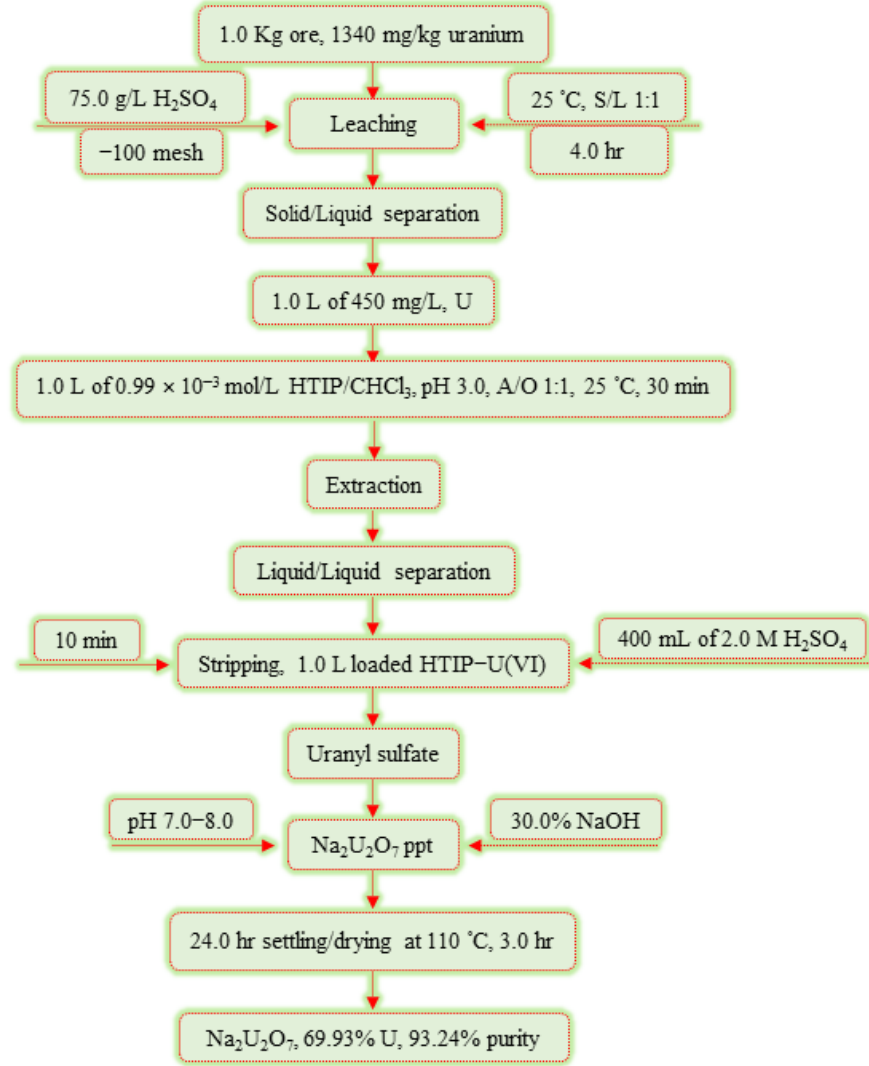
Figure 13. Flow chart illustrating the production of Na 2 U 2 O 7 from G. Gattar granite ore sample using HTIP chelating ligand.